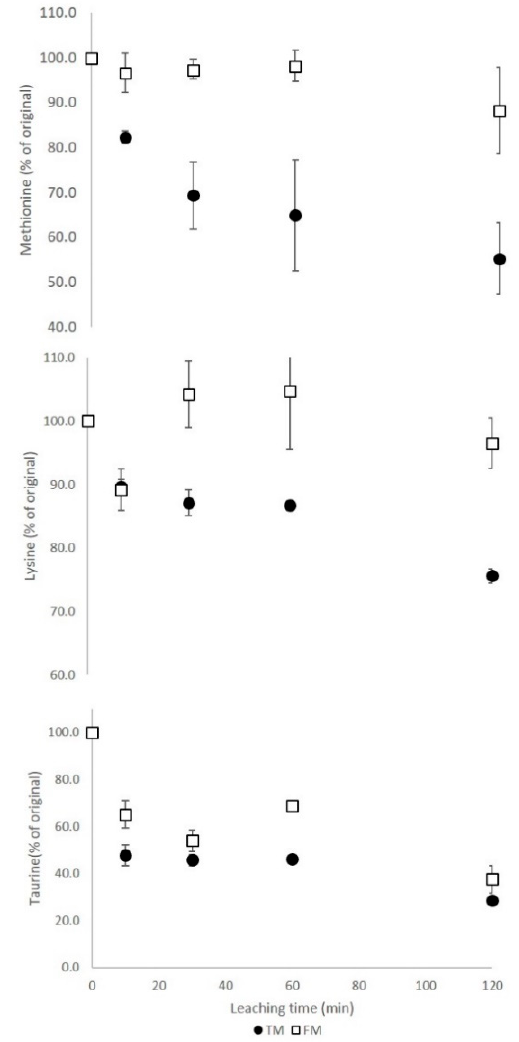
Figure 4. Methionine, lysine and taurine content, expressed in proportion of original, of two diets subject to leaching for various duration. Note the rapid drop of each amino acid from time 0 to the first sampling time (10 min), particularly for the TM diet.